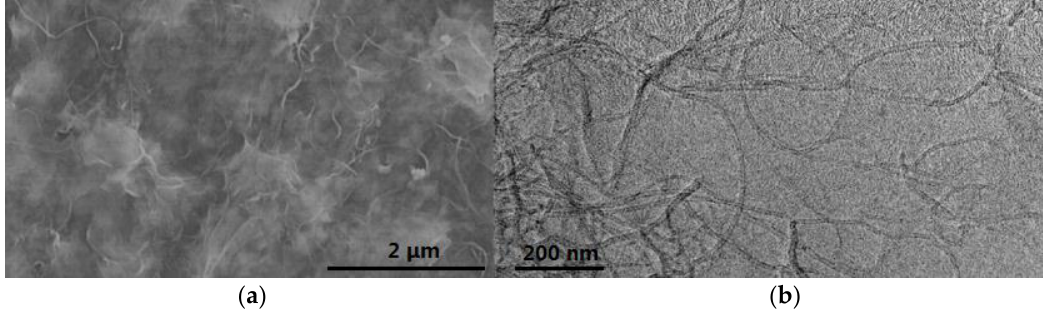
Figure 9. ( a ) SEM image and ( b ) TEM image of CNTs-based composite membrane [87].